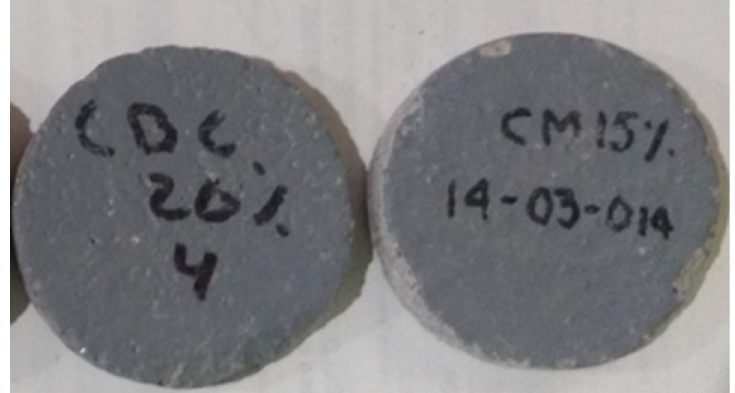
Figure 2. Vinyl paint applied in cross sections of cylinders.